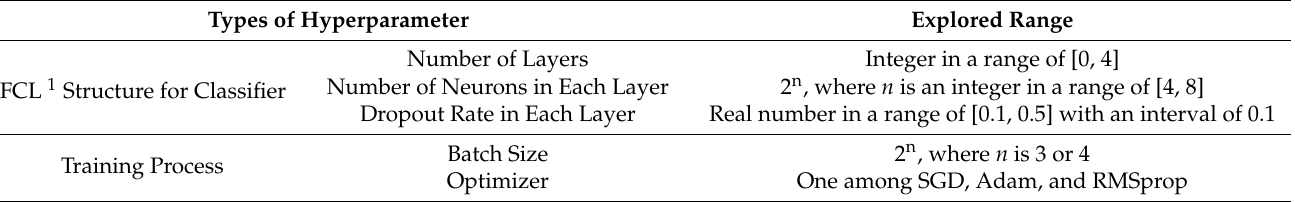
Table 1. Explored hyperparameter space.